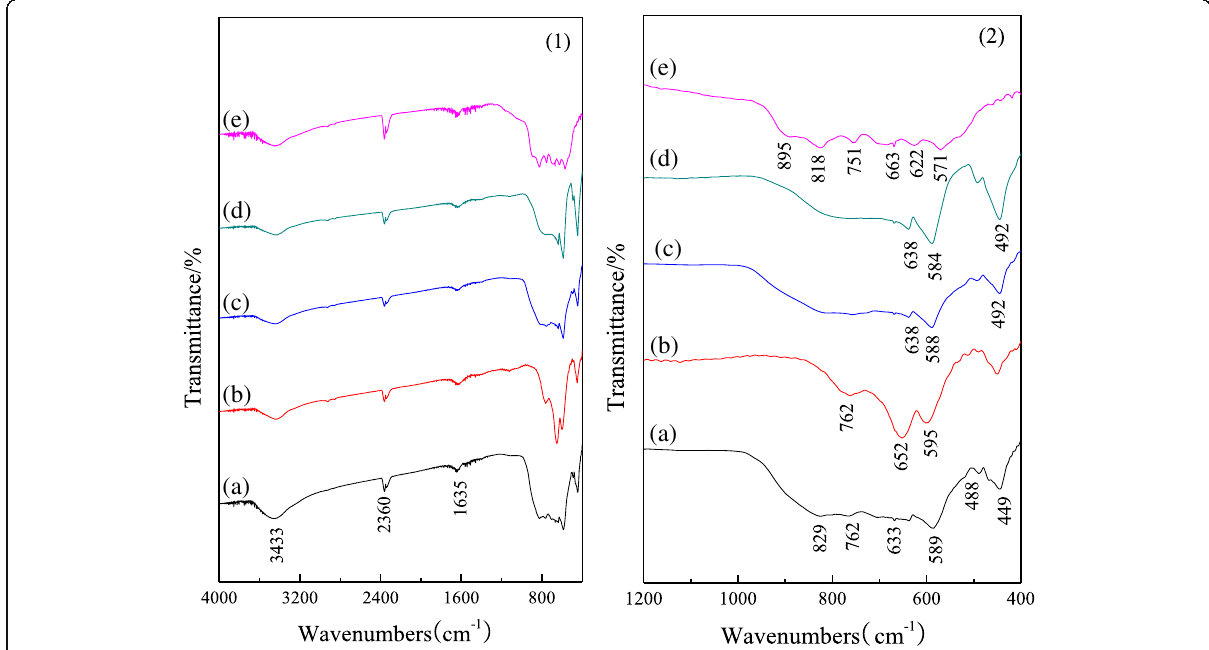
Fig. 2 FT-IR spectra of nano alumina rods doped with different ions: a undoped alumina, b Cr-doped alumina, c Fe-doped alumina, d Mg-doped alumina, and e the alumina prepared from the chromium-containing alumina